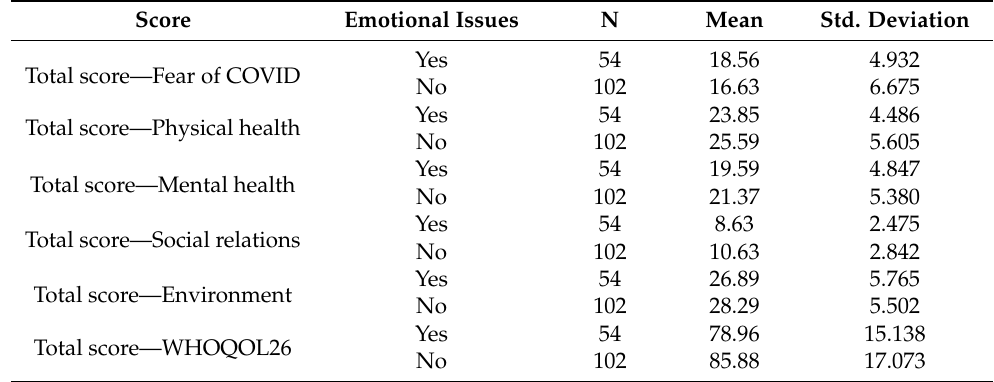
Table 4. Cross-reference between the total scores of participants reporting emotional issues.